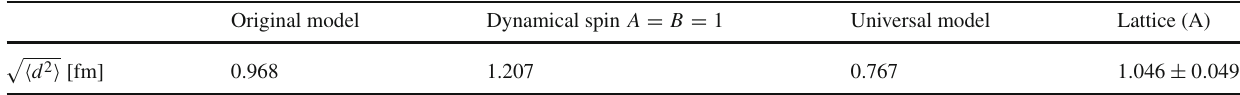
Table 2 Values of the 3D mean partonic distance in the pion, Eq. (19), obtained within the lattice and the model based on the the AdS/QCD